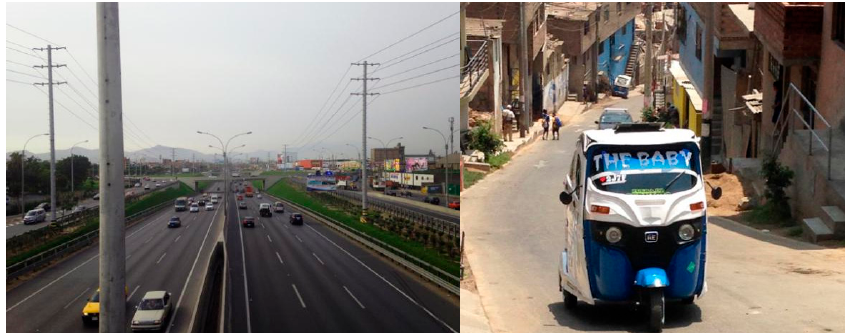
Figure 7. ( Left ): Panamericana Norte Freeway; ( Right ): mototaxi in Independencia district (Northern Lima). Source: Franco Jauregui-Fung (2018).